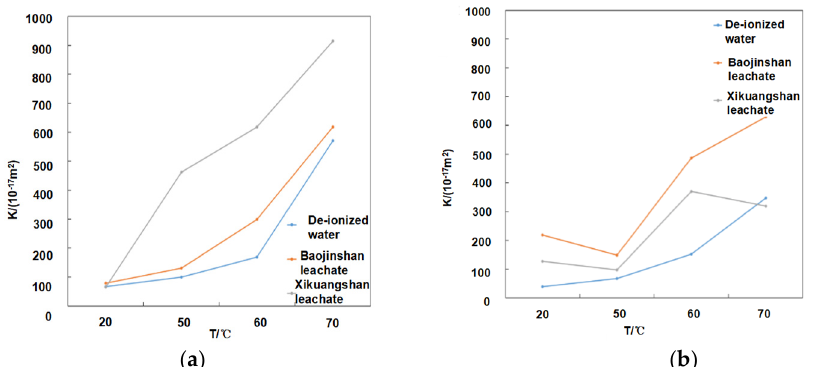
Figure 7. Intrinsic permeability of two bentonites (( a ) for bentonite A and ( b ) for bentonite B) at different temperatures.